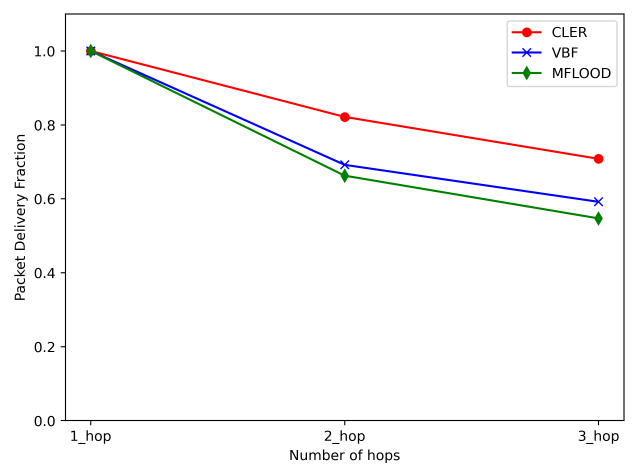
Figure 8. Packet delivery fraction of different